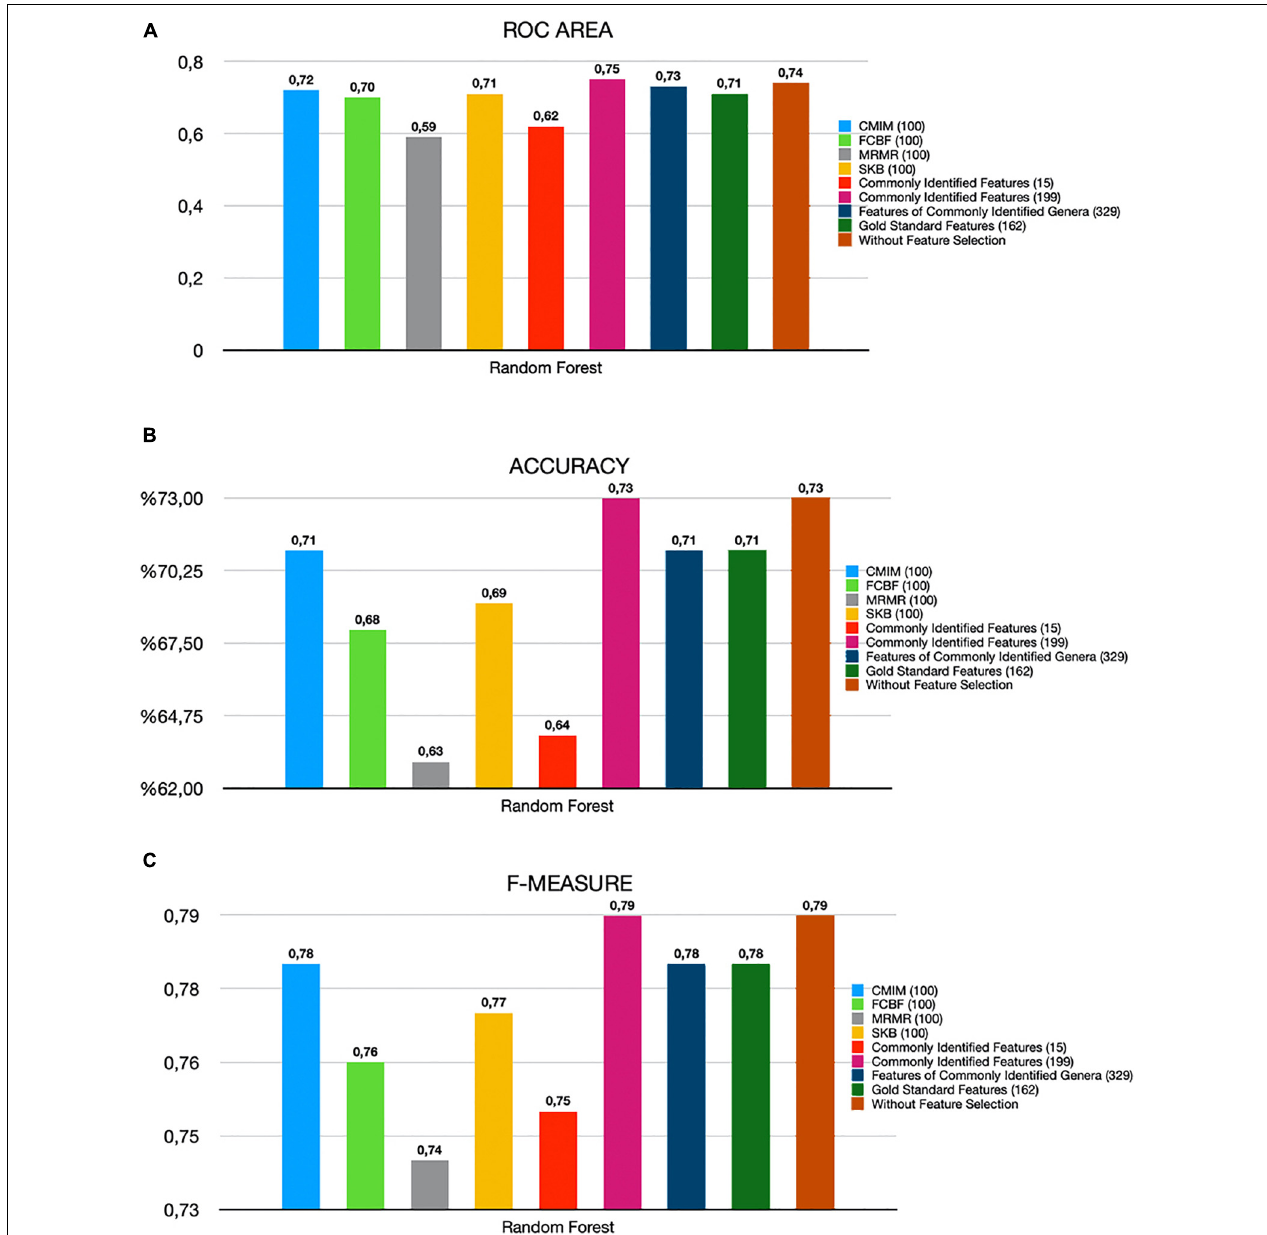
FIGURE 3 | Comparative evaluation of different feature selection methods based on (A) ROC area, (B) accuracy, and (C) F-measure